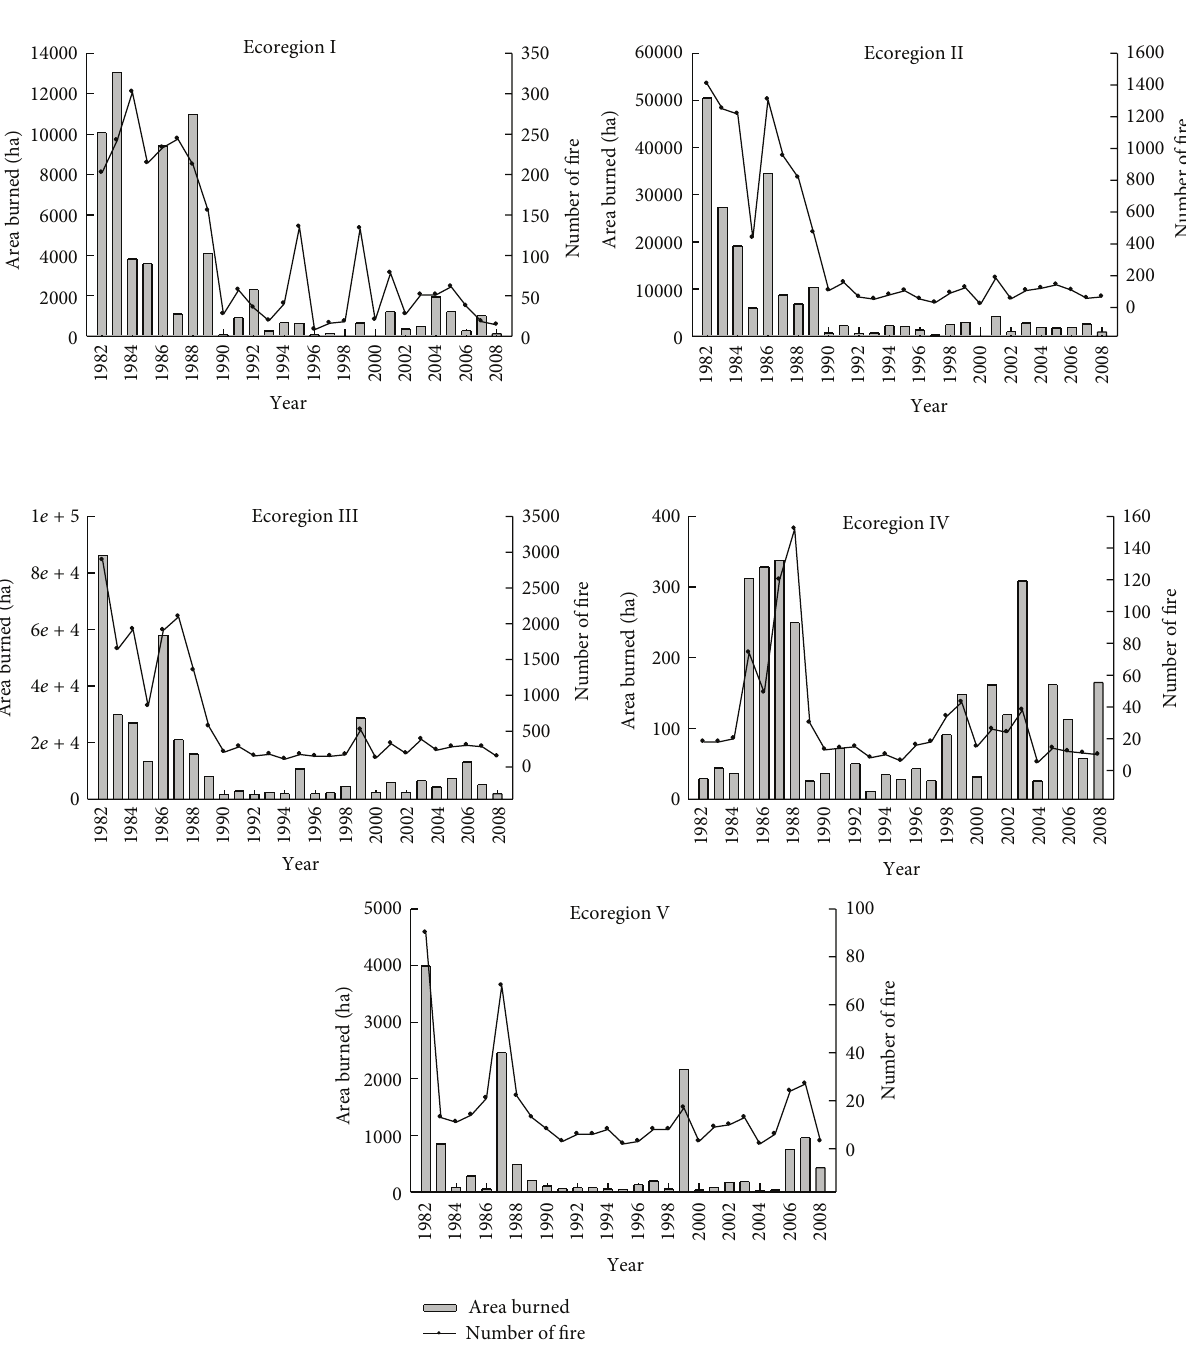
Figure 3: The changing trend of the annual number of fires and area burned for five ecoregions in Yunnan province, during the period